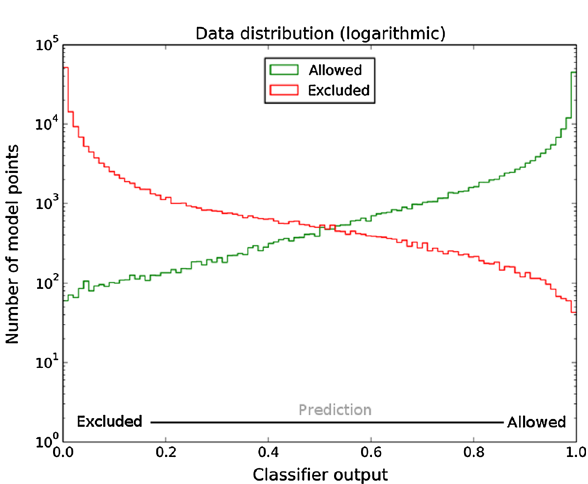
Fig. 2 Distribution of the number of true allowed or excluded points by ATLAS [6] as a function of the classifier output